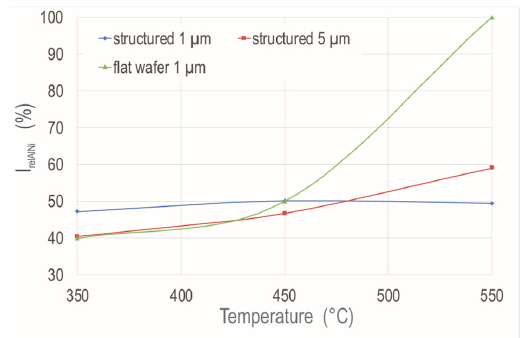
Figure 7. Relative intensity I AlNi for total thickness of 1 µm and 5 µm compared with 1-µm-thick layer on flat reference wafer.